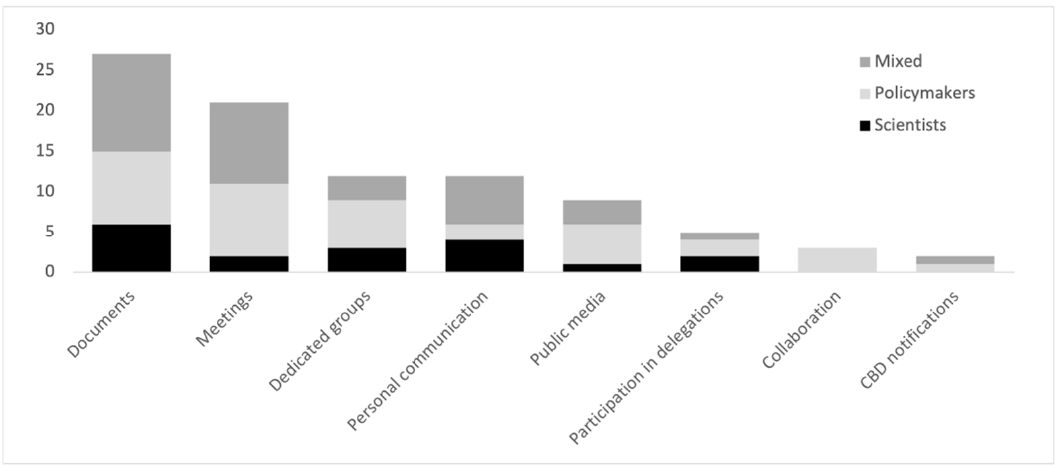
Figure 1. Mechanisms perceived to be best at communicating biodiversity science to policy. The number of respondents is indicated on the vertical axis and the category of mechanism on the horizontal axis.